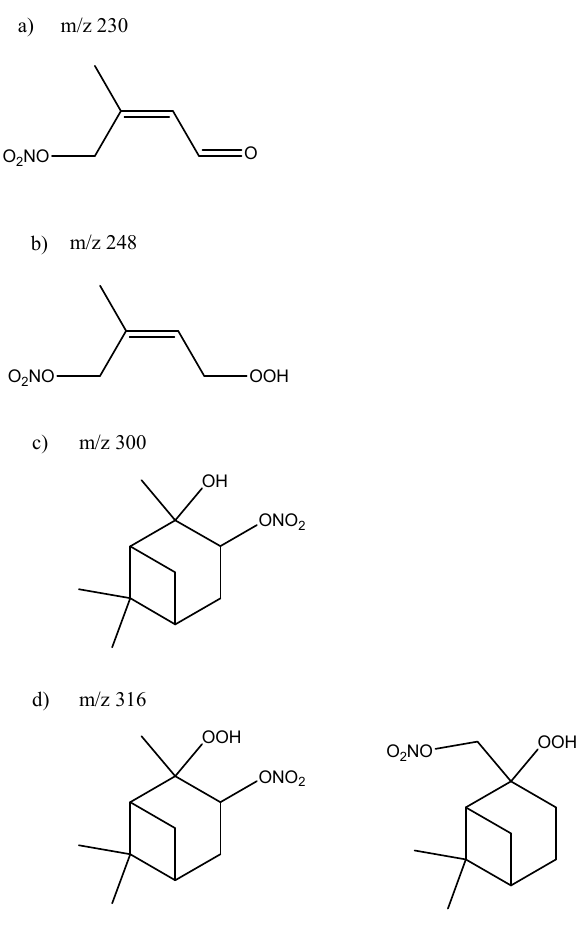
Fig. 4. Proposed structures for even mass signals listed in Table 2. m/z 248 could also be due to MBO + NO 3 chemistry, but since the NO 3 rate constant is ∼ 500 times lower than with α -pinene, and ∼ 60 times lower than isoprene, it is expected to be a minimal contribution.